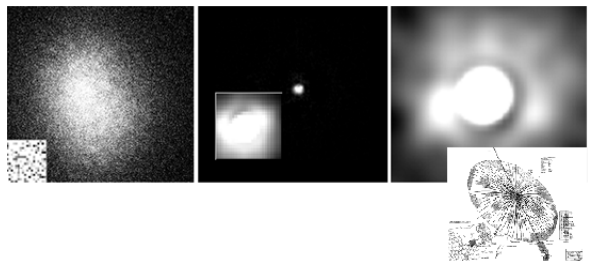
Figure 1. Restored image of the AES «Orion»